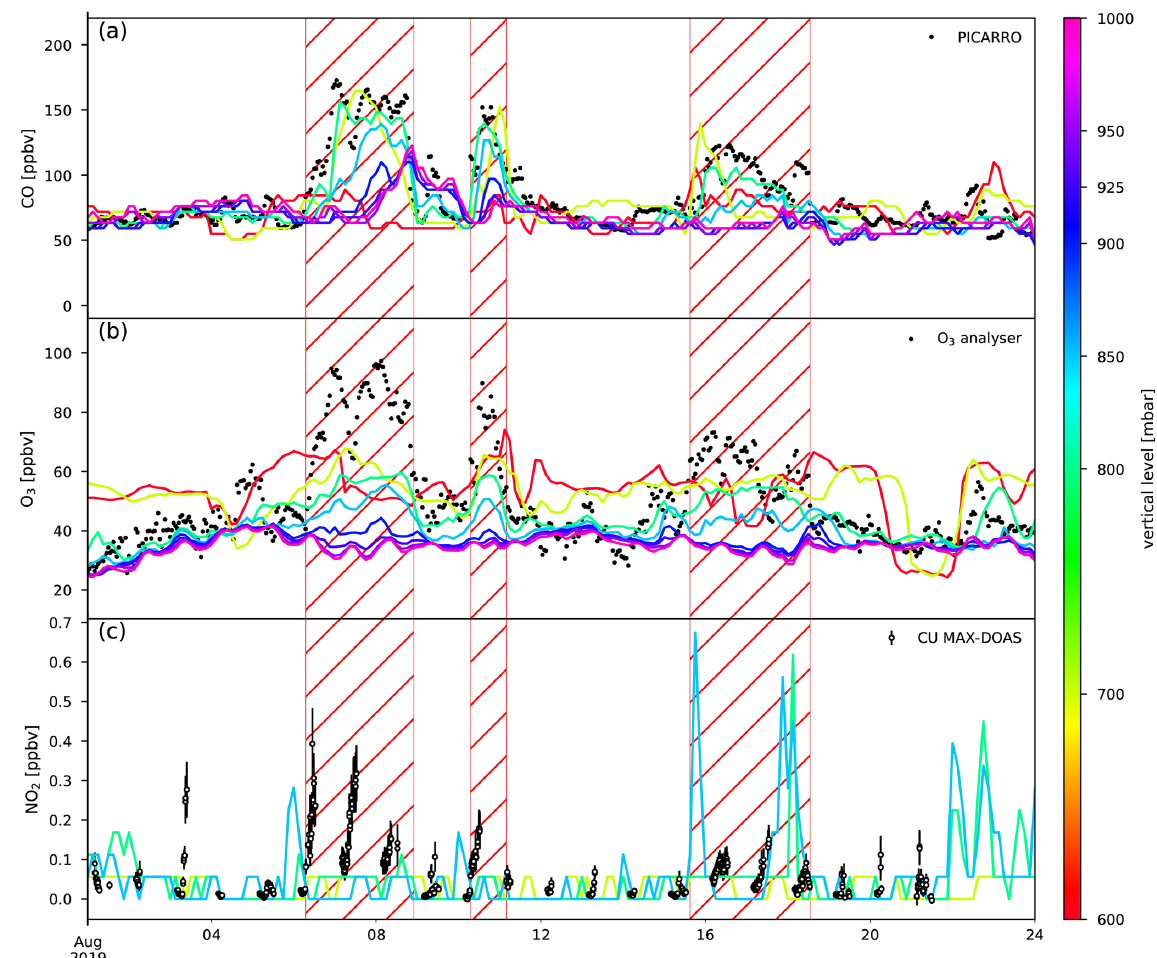
Figure 3. Comparison between measured (black dots) and calculated mixing ratios (coloured lines) of CO (a) , O 3 (b) and NO 2 (c) from CAMS. The coloured lines indicate the lowest eight pressure levels in the model (1000, 950, 925, 900, 850, 800, 700 and 600mbar). The hatched red area represents the different BB